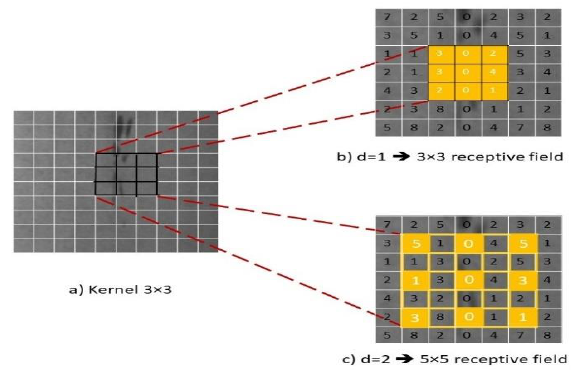
Figure 4. Dilated Convolution in DSTEELNet.